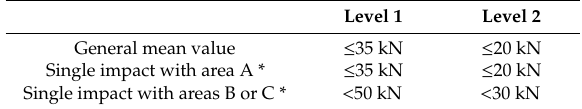
Table 2. Transferred force and performance levels [16].